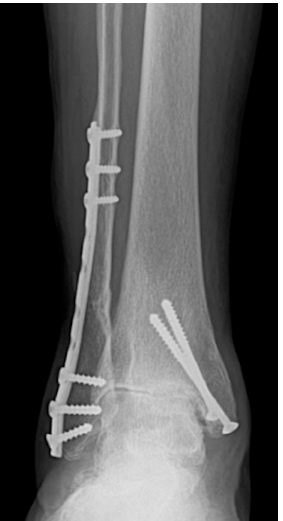
Figure 1. Advanced symmetrical ankle OA secondary to ankle fracture dislocation surgically treated 8 years previously.